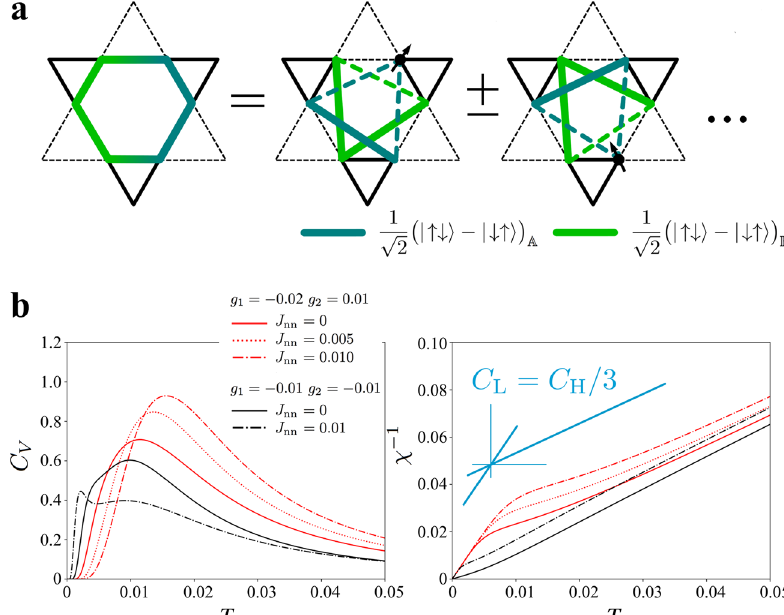
Fig. 4 Thermodynamic properties of a single resonating hexagon. a Schematics of the resonating hexagon with one dangling spin, as given by Eq. (2). Dashed and bold lines represent resonating valence bonds for each plaquette state. Note that the valence bonds have different weights in each plaquette state, and the location of dangling spins (black arrows) is not uniquely de fi ned in the hexagon. b Speci fi c heat and inverse spin susceptibility of a single resonating